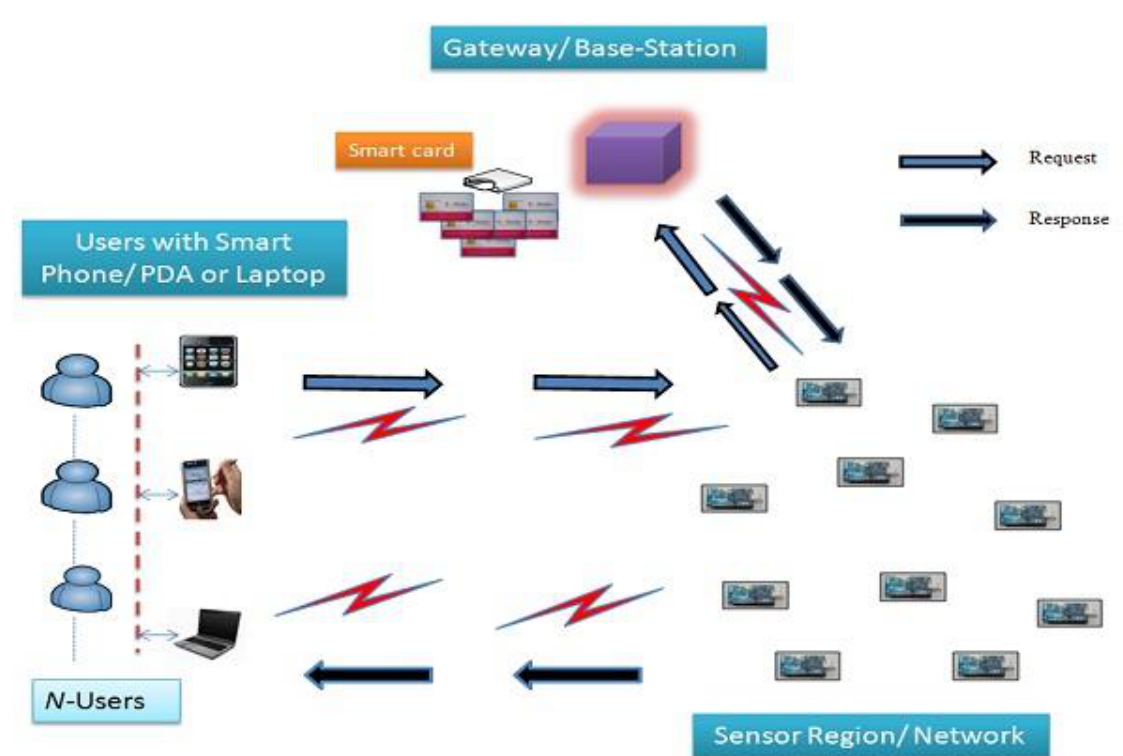
Figure 1. The basic system architecture for